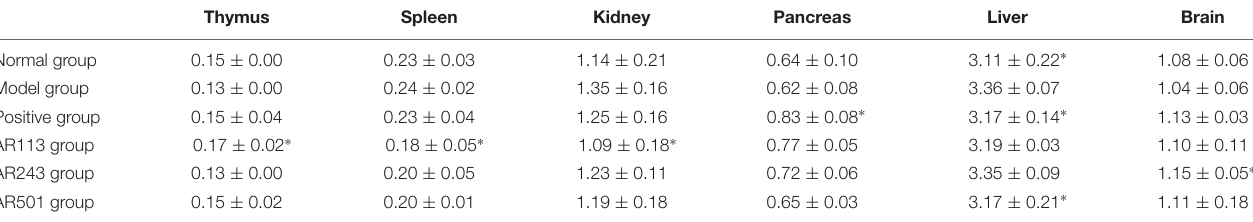
TABLE 2 | Effect of LAB on the organ index.